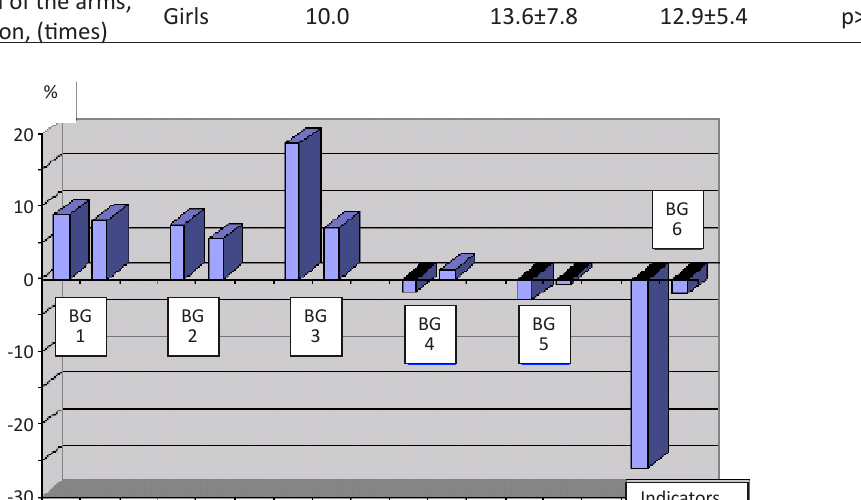
Figure 1. Changes in the indicators of physical readiness of students involved in sports and outdoor games: 1 – shuttle run 3×10 m; 2 – Cooper’s test (12 min run); 3 – lean forward from a standing position on a gymnastic bench; 4 – long jump from a place; 5 – raising the trunk from a prone position, in 1 min; 6 – pulling up on a high bar (boys), flexion- extension of the arms, in the lying position